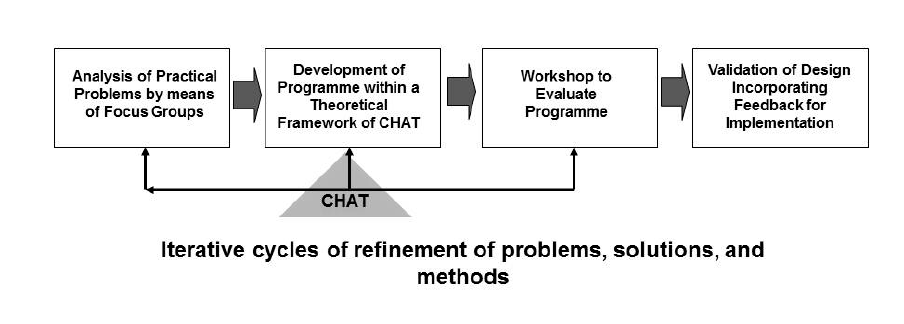
FIGURE 1: Outline of design phases and cycles Source: Adapted from Reeves